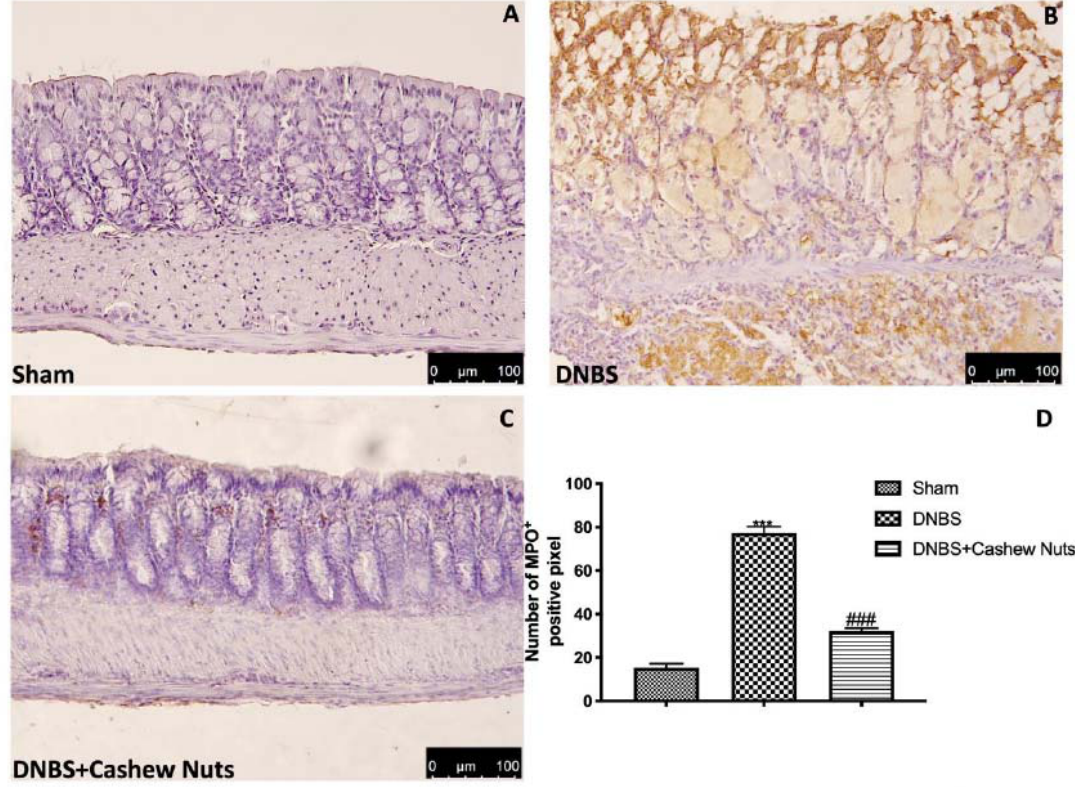
Figure 4. The e ff ects of cashew nuts on myeloperoxidase (MPO) expression after DNBS injection. Immunohistochemistry for MPO was evaluated in sham ( A ), DNBS ( B ), DNBS + cashew nuts ( C ). The results are expressed as % of positive pixels ( D ). Images are figurative of at least three independent experiments. Values = means ± SEM of six animals in each group; *** p < 0.001 vs. sham; ### p < 0.001 vs.